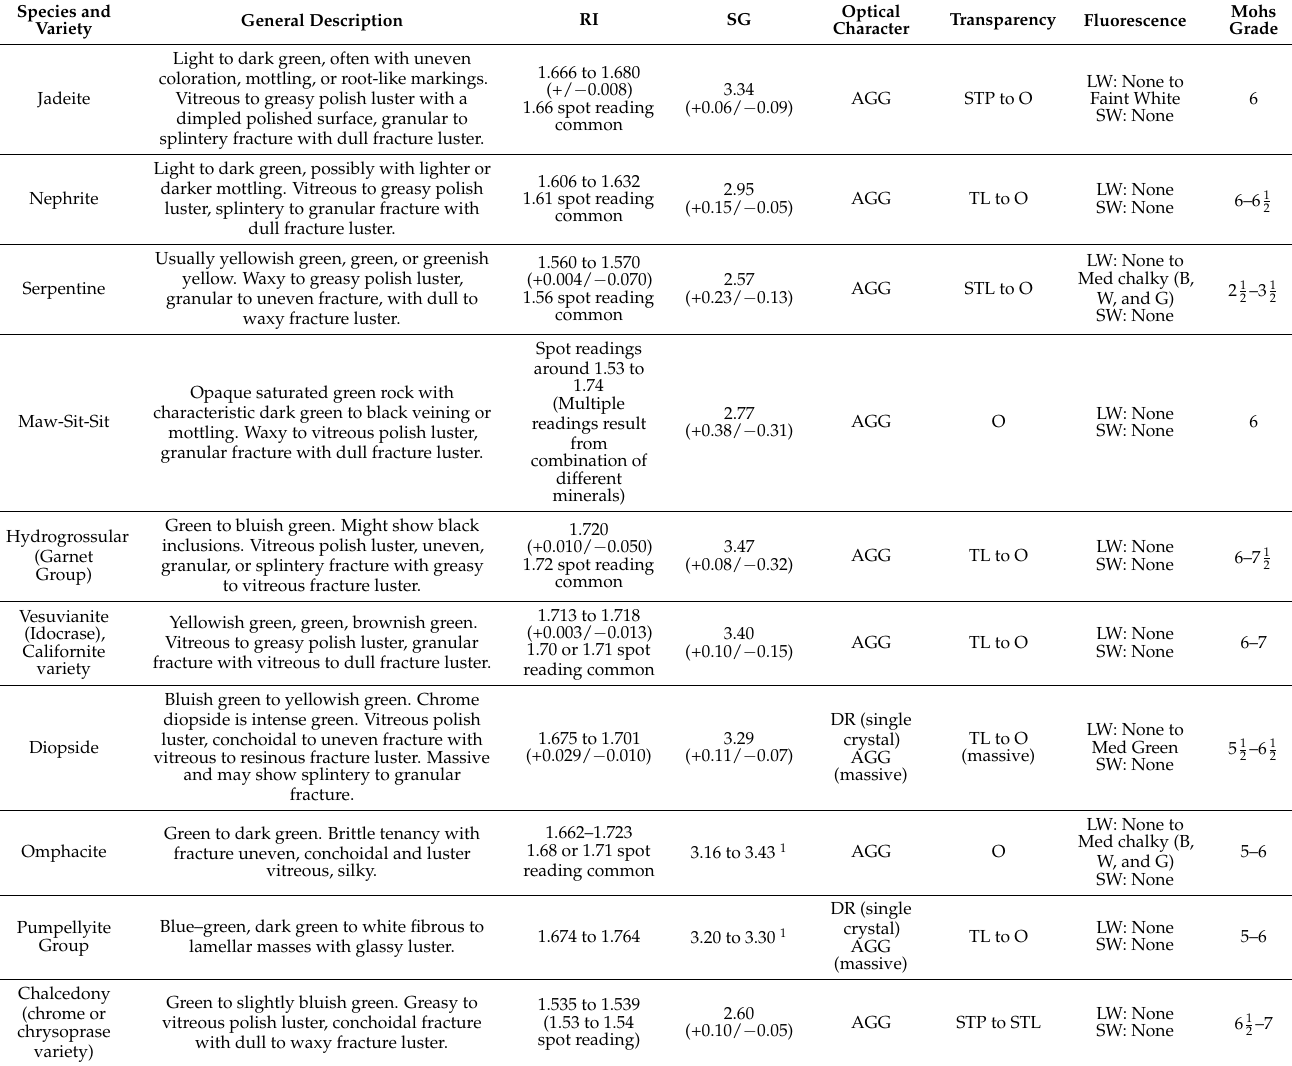
General Description RI SG Optical Character Transparency Fluorescence Mohs